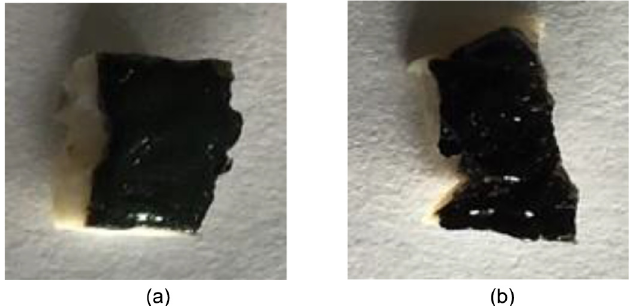
Fig. 1. (A) Tissue inked with nail enamel. (B) Tissue inked with